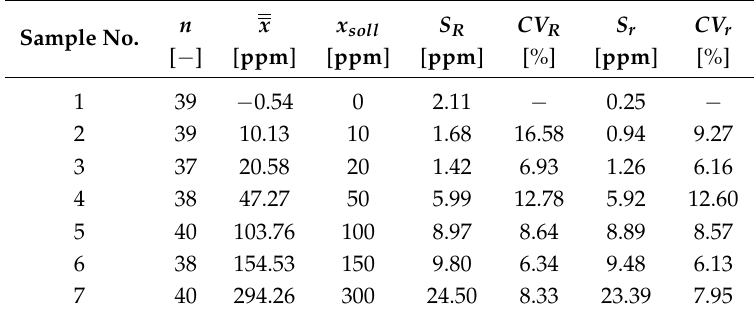
Table 4. Data of inter-laboratory trials from the four OiW monitors based on ordinary least square (OLS) calibration. Sample No.